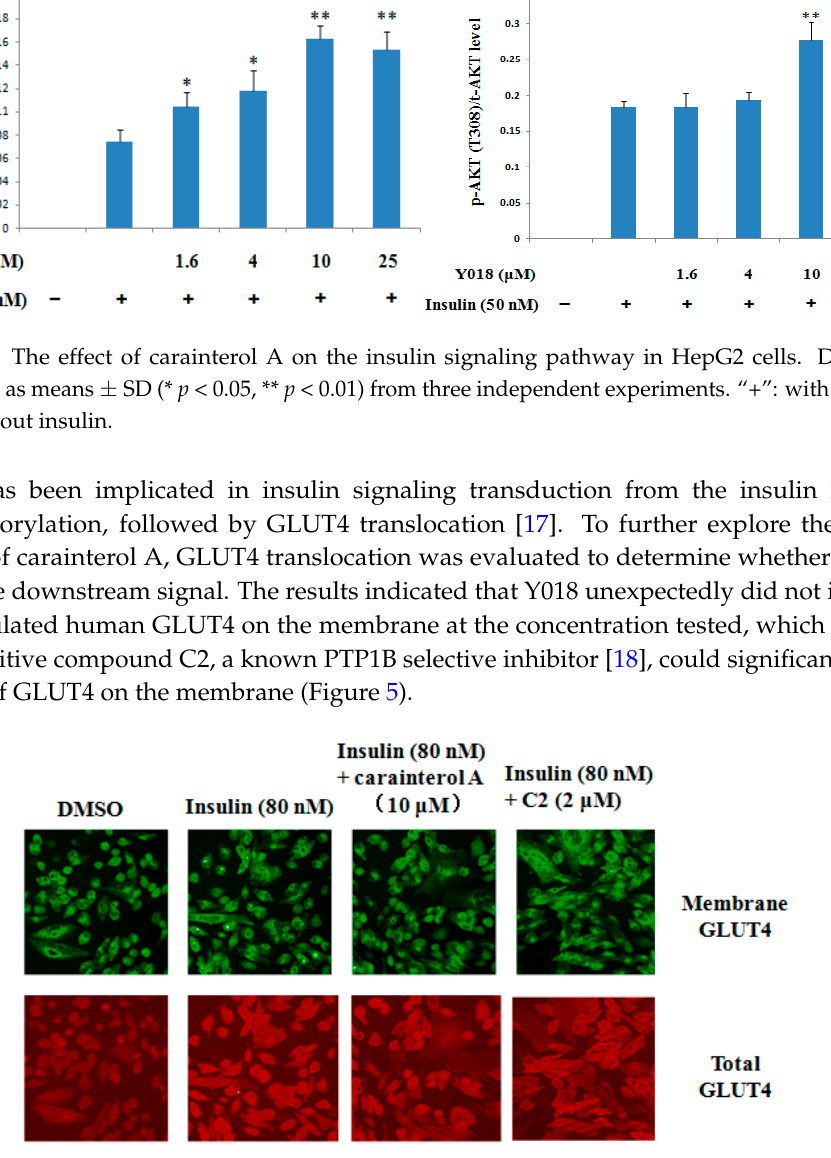
Figure 5. GLUT4 membrane translocation.